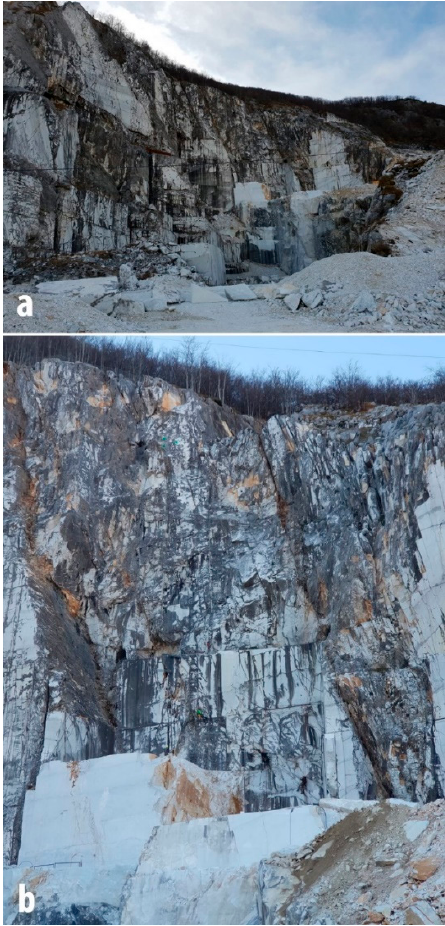
Figure 6. ( a ) strike-slip faults cross-cutting the Marmi s.s. Formation in the quarry area; ( b ) detail of the fault and damage zone.